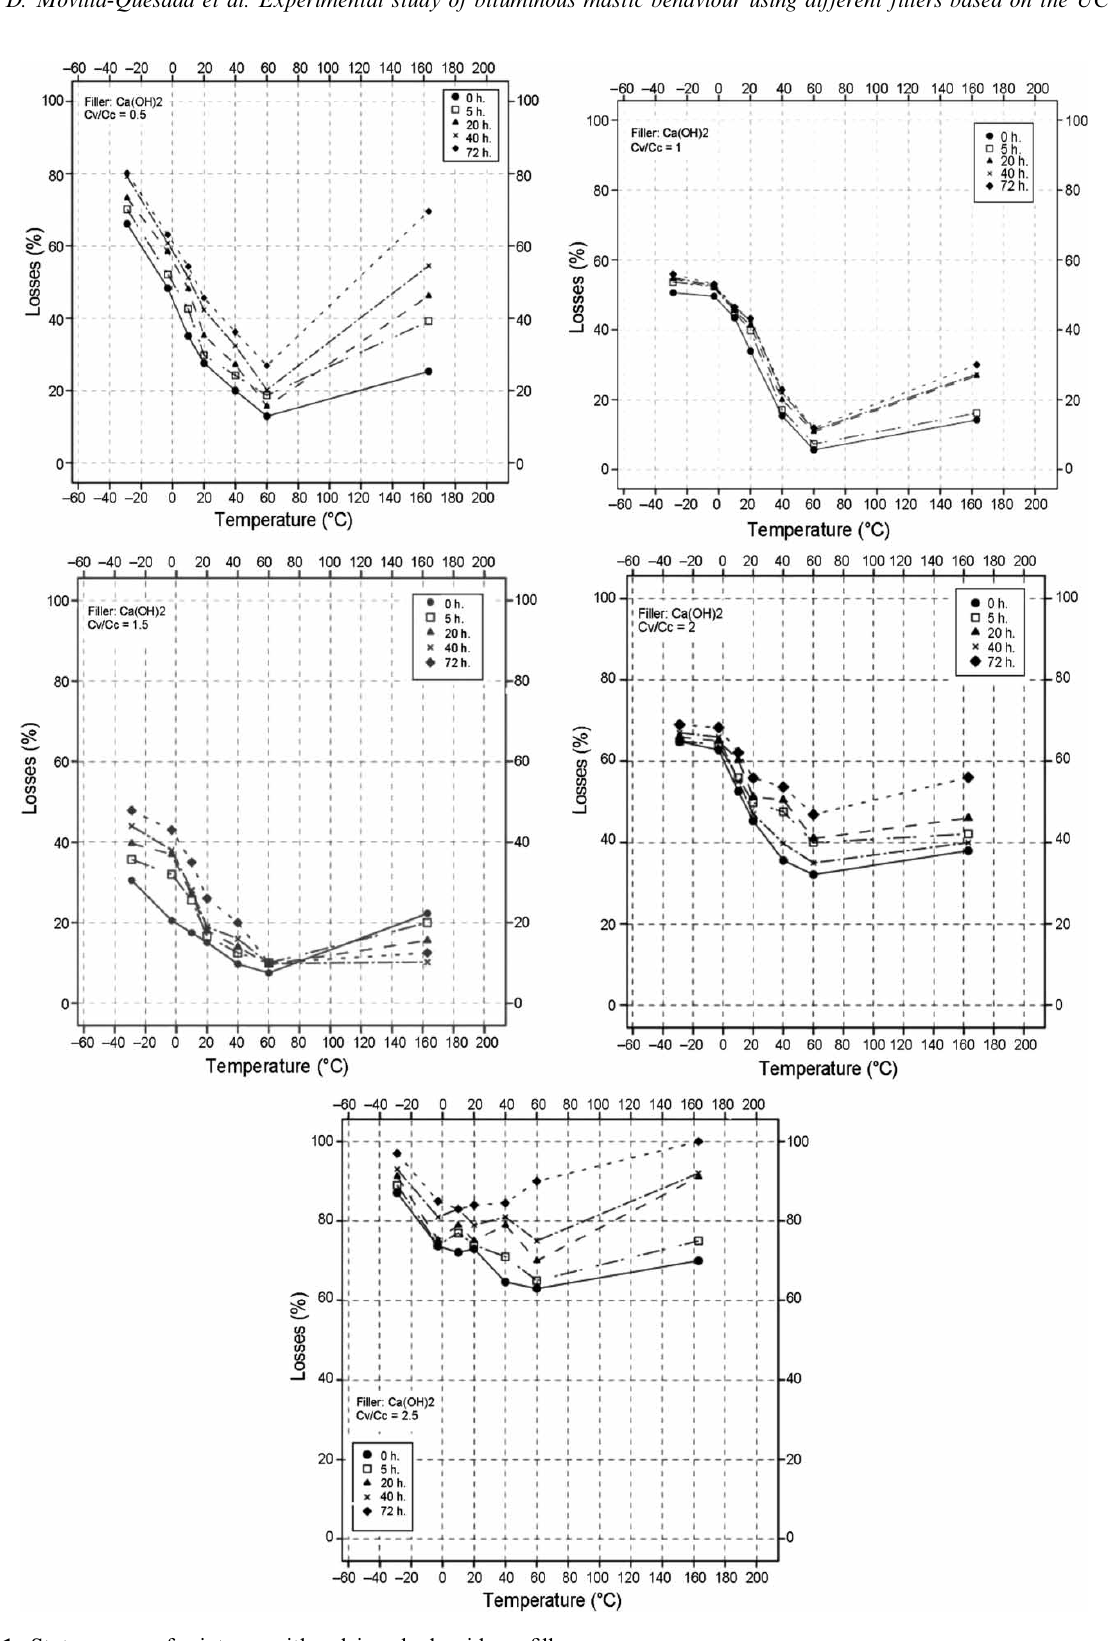
Fig. 1. State curves of mixtures with calcium hydroxide as